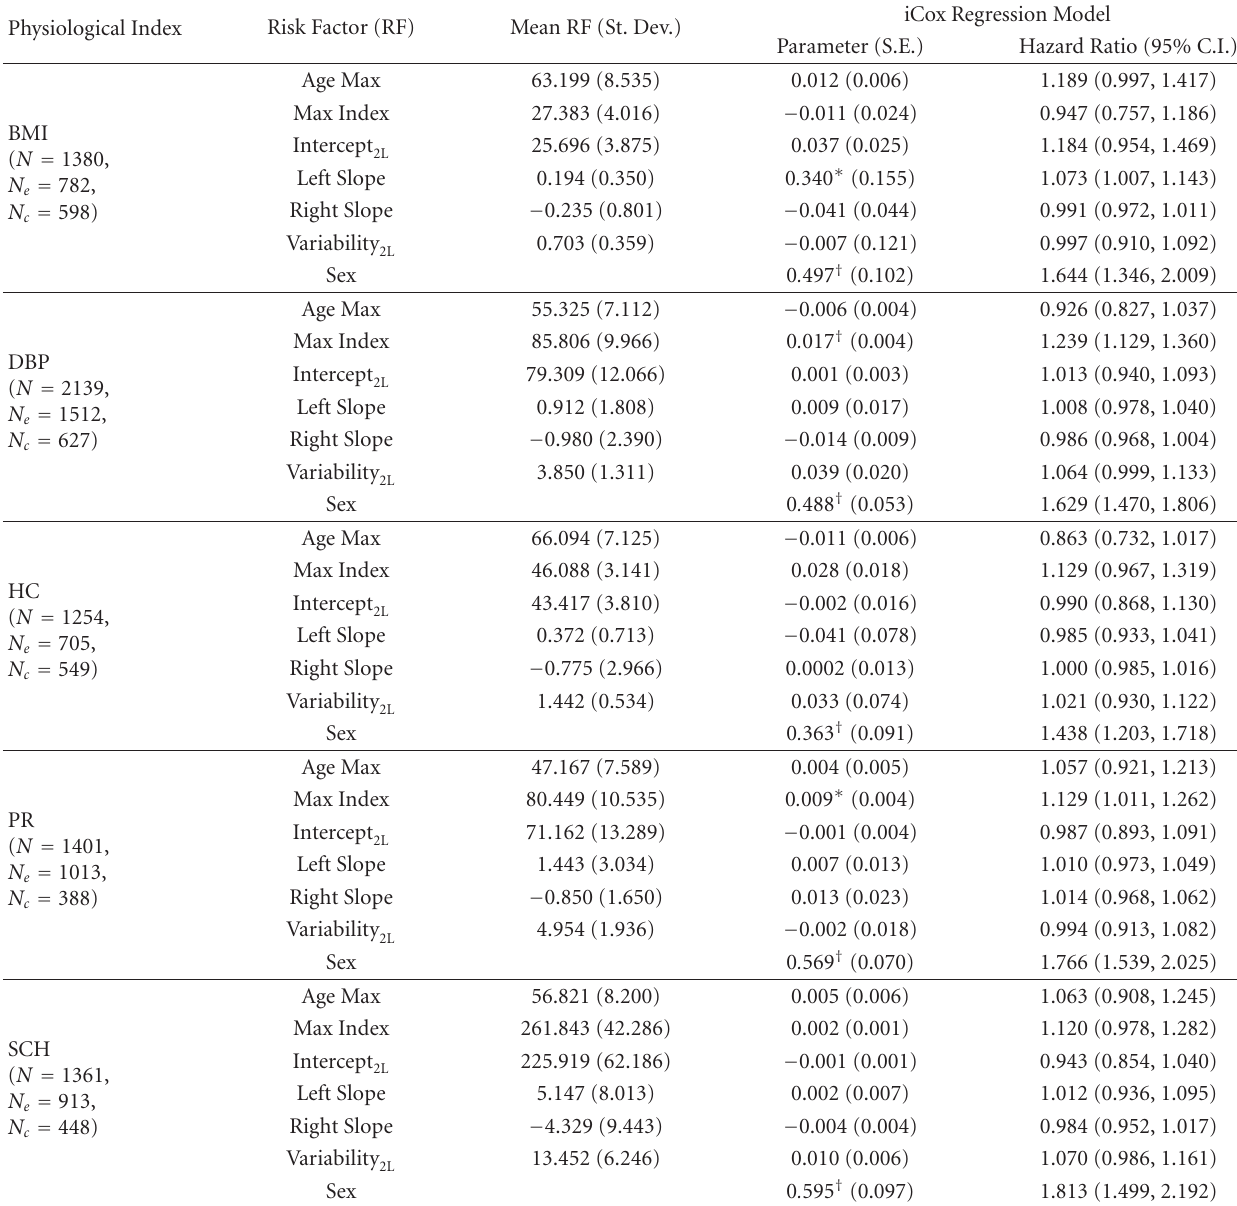
Table 4: E ff ect of “dynamic” risk factors calculated from individual trajectories of physiological indices with nonmonotonic patterns on risk of onset of “unhealthy life” in the Framingham Heart Study (original cohort) estimated by the Cox proportional hazards